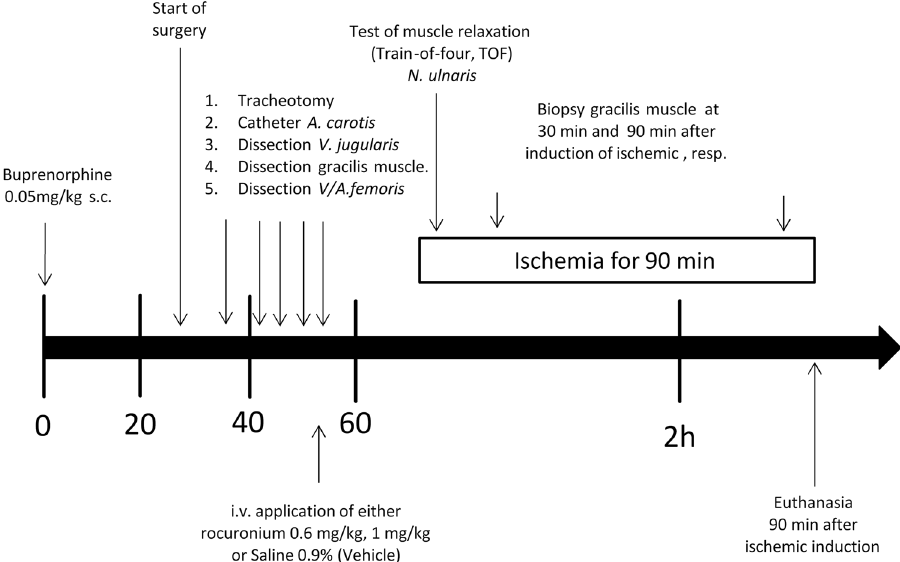
Figure 1. Flowchart of experimental design. Male Spargue Dawley (SD) rats were subjected to 90 min of ischaemia and finally euthanized. During the 90 min of ischaemia, rats were kept under general anaesthesia with isoflurane and buprenorphine. To achieve ischaemia, both femoral artery and vein were ligated with 4-0 silk. In addition, the right internal jugular vein was cannulated and used for the administration of the investigated drugs. For further details see the material and methods